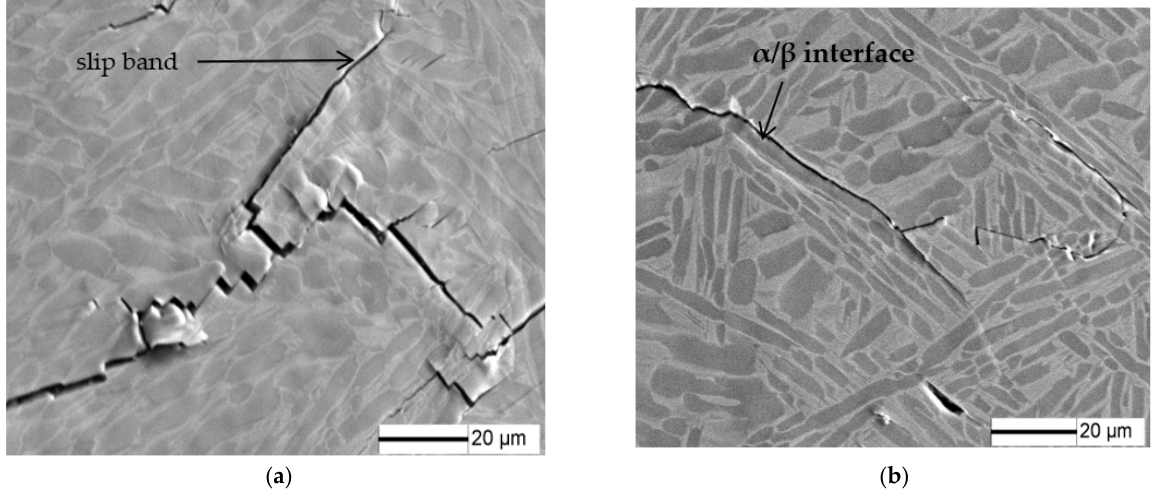
Figure 13. The morphology of the fatigue sub ‐ crack and microstructure (Backscatter electron mi ‐ croscopy): ( a ) Δ ε t = 2.0%, N f = 1302 cycles; ( b ) Δ ε t = 1.4%, N f = 7988 cycles.